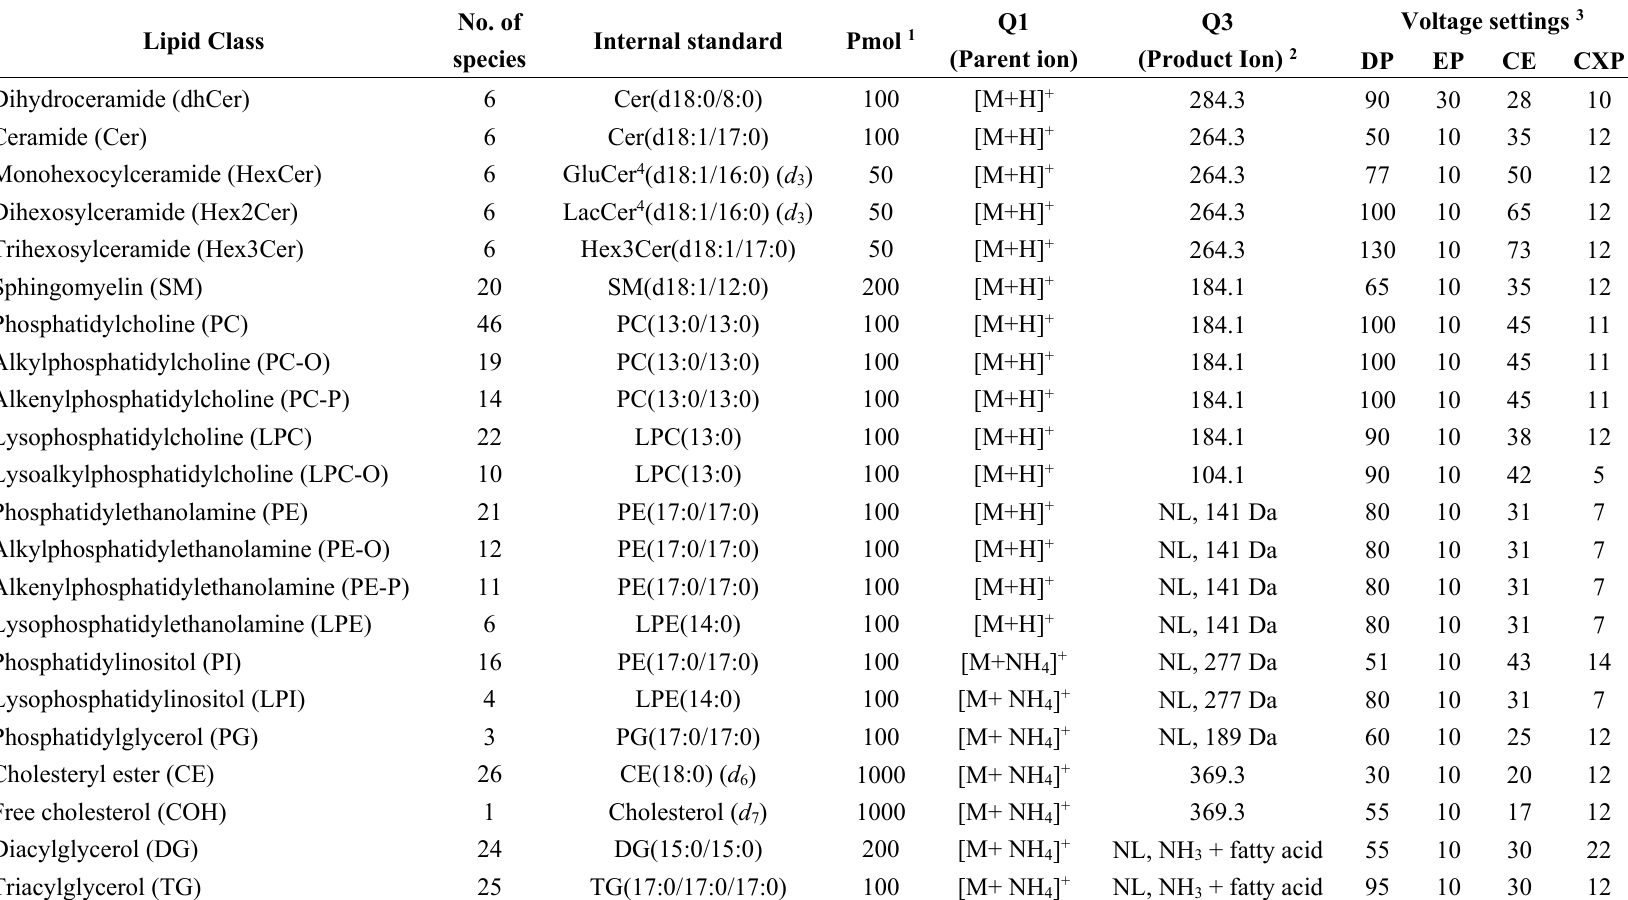
Table 1. Conditions for tandem mass spectrometry quantification of major lipid species identified in human plasma. No. Lipid Class